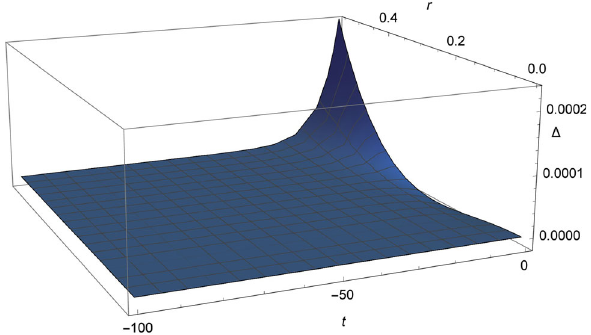
Fig. 6 (cid:14) = p r − p t , c 1 = 0 . 81, c 2 = 0 . 5, c 3 = − 10, c 4 = − 10, ζ = − 0 . 2, R = 6 . 62, r = 0 . 55 and (cid:7) = 0 . 1 0